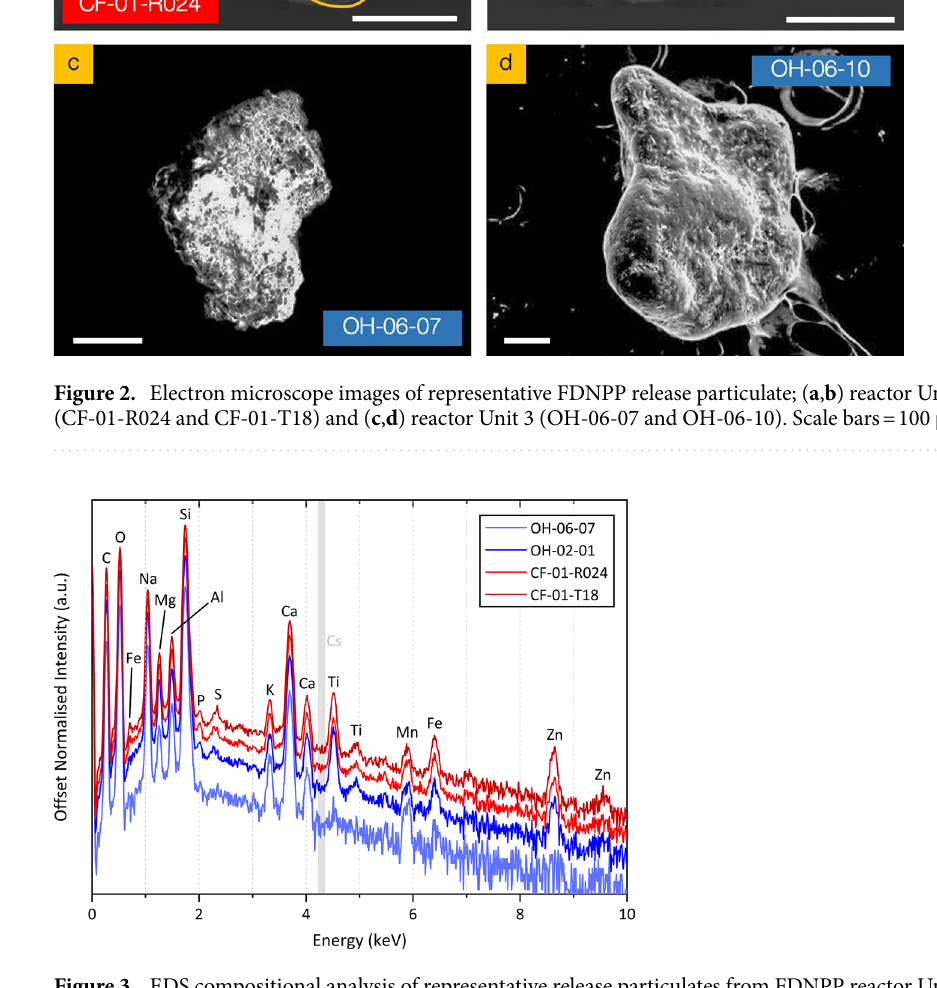
Figure 3. EDS compositional analysis of representative release particulates from FDNPP reactor Unit 1 (red) and Unit 3